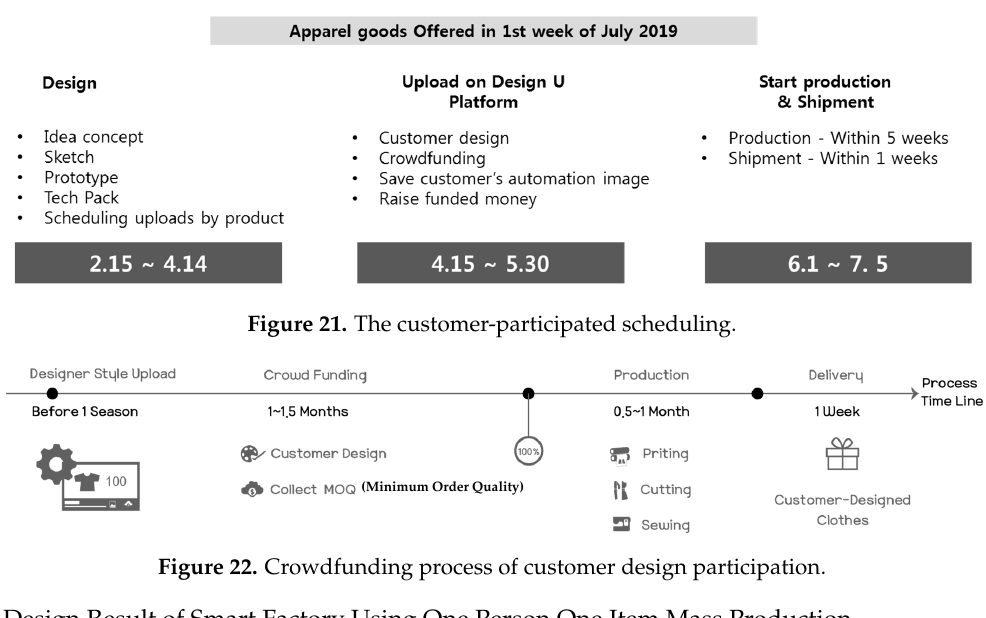
Figure 20. A supply chain schedule suitably changed for the production method of the Design U service.